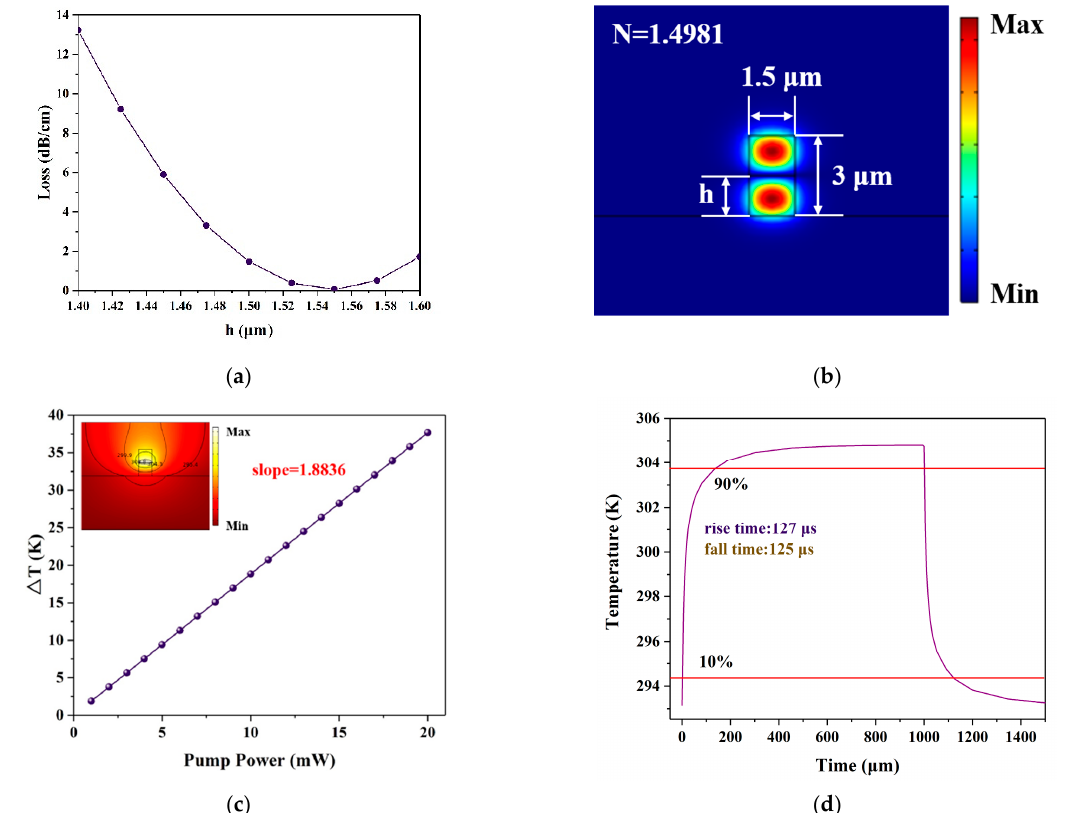
Figure 8. Switching characteristics without silicon substrate. ( a ) The relationship between the loss and graphene vertical position h; ( b ) electric field diagram of the first-order mode; ( c ) the relationship between waveguide temperature variation and pump power; and ( d ) time response of the optical switch.